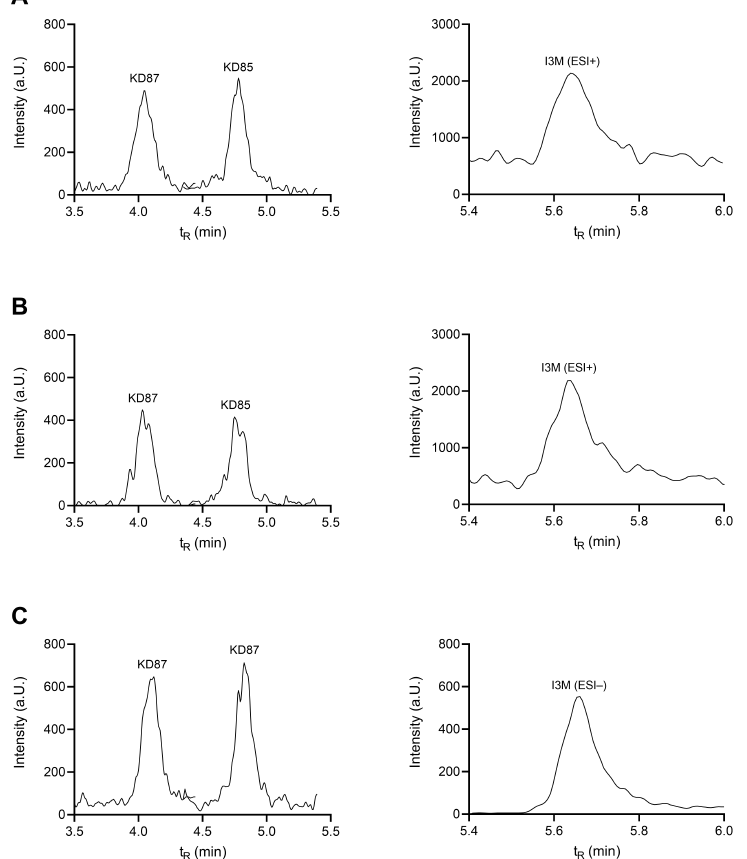
Figure 4. Representative total ion chromatograms for LLOQ after acidic plasma precipitation ( A ), alkaline plasma extraction ( B ), and alkaline DMEM extraction ( C ). On the left side, the peaks of KD87 and KD85 at 0.67 nM (0.295 ng/mL) ( A ), 1 nM (0.441 ng/mL) ( B ), and 1 nM (0.441 ng/mL) ( C ), respectively, are shown. On the right side, the signal is shown for I3M (ESI+) at 0.67 nM (0.152 ng/mL) ( A , B ) and for I3M (ESI − ) at 1 nM (0.277 ng/mL) ( C ),